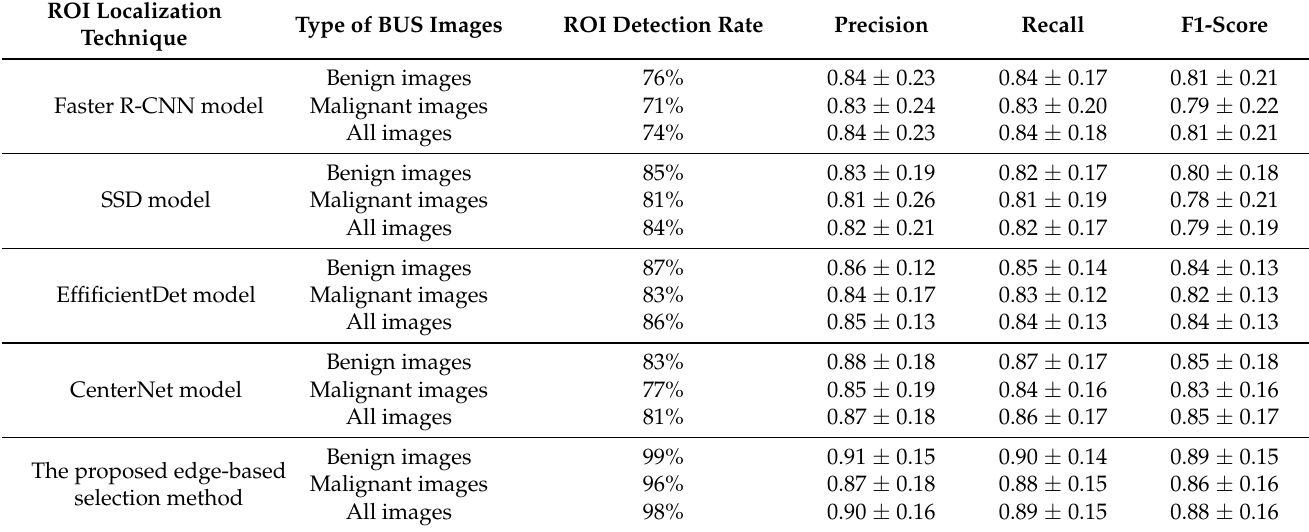
Table 4. The ROI detection rates and the mean ± standard deviation values of the precision, recall, and F1-score obtained using the Faster R-CNN, SSD, EfficientDet-D0, and CenterNet object-detection models as well as the proposed edge-based selection method based on the BUSI dataset.